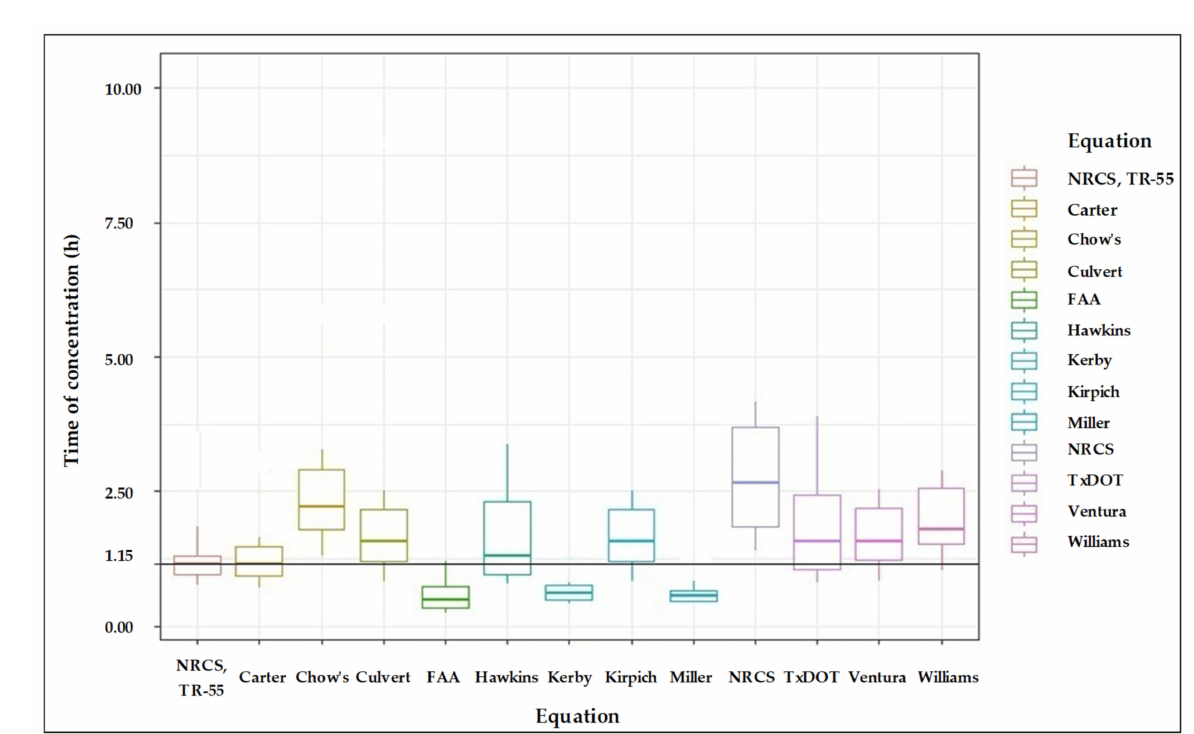
Figure 5. Whiskers diagram.